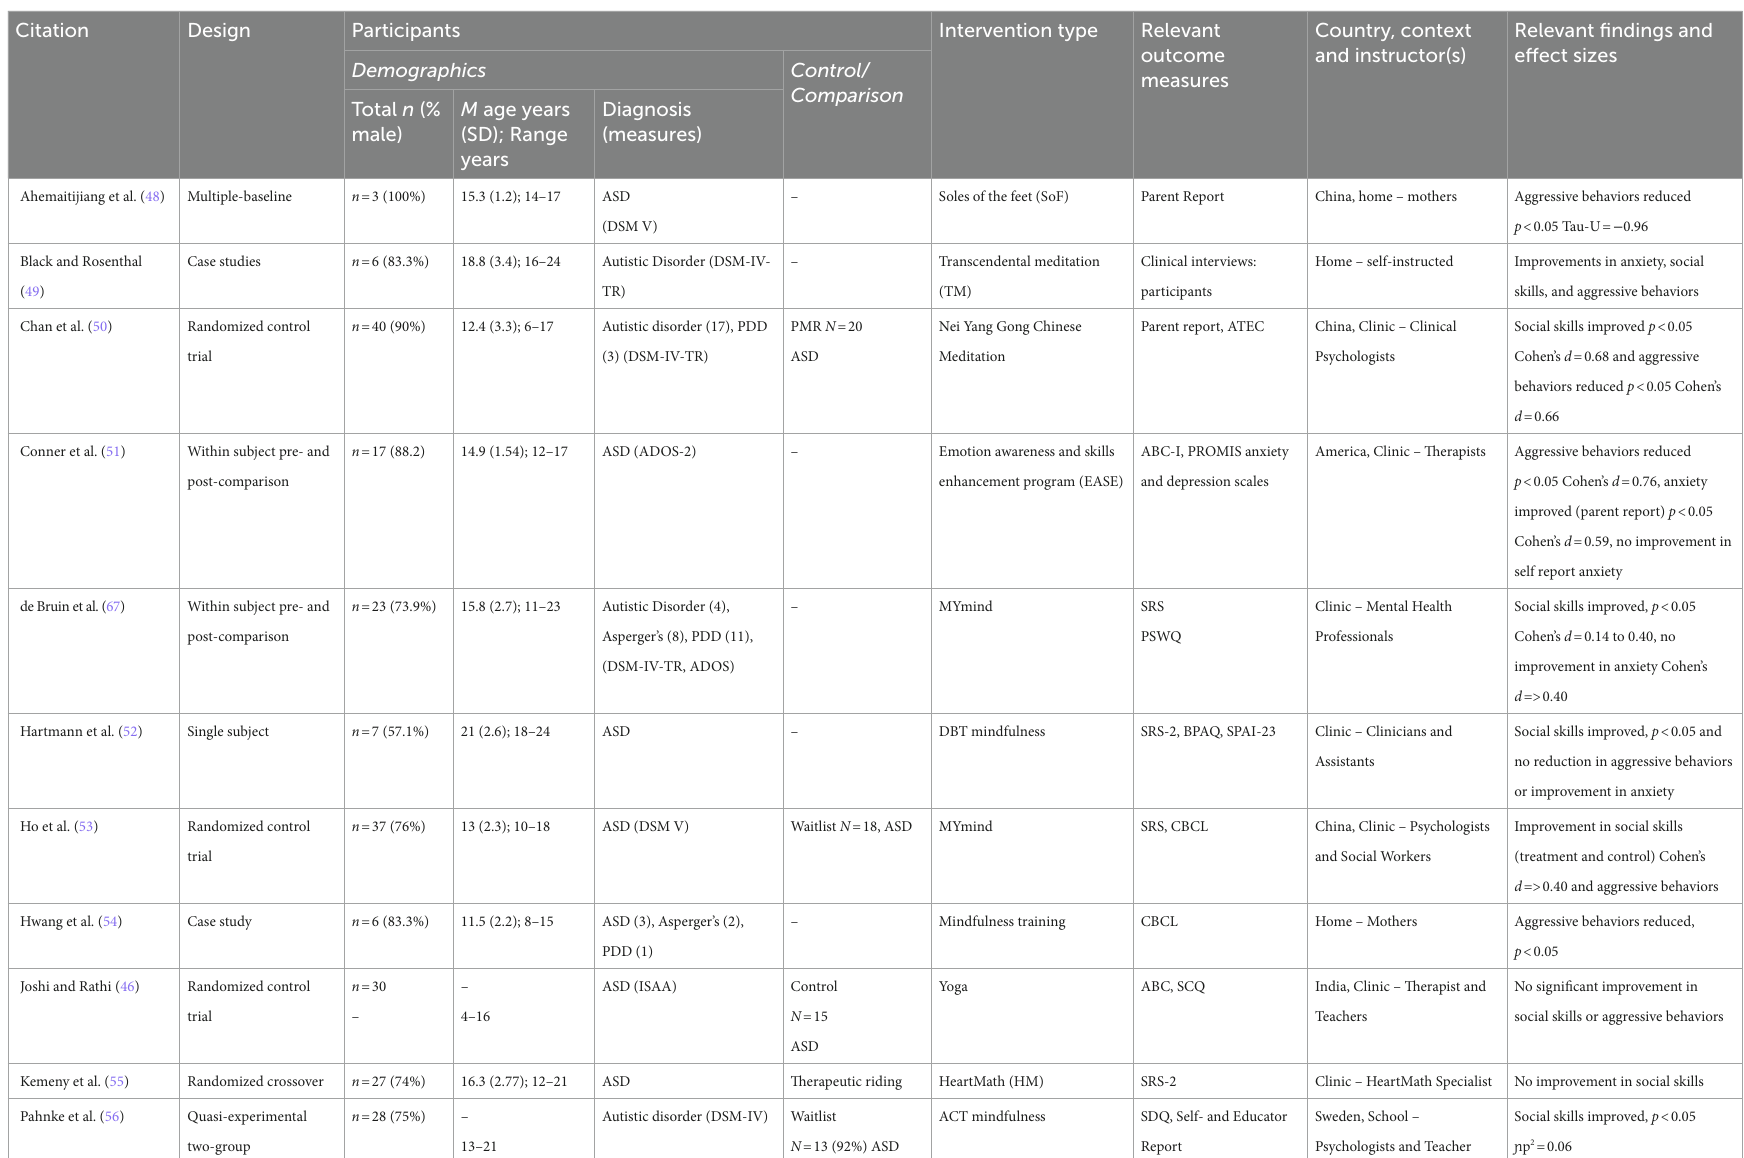
TABLE 1 Characteristics of studies included in systematic